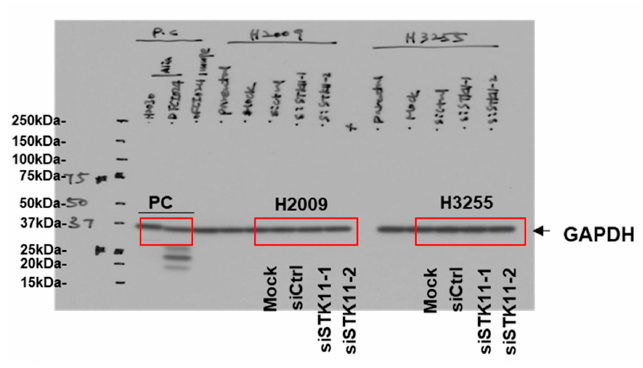
Figure A1. Uncut immunoblots.